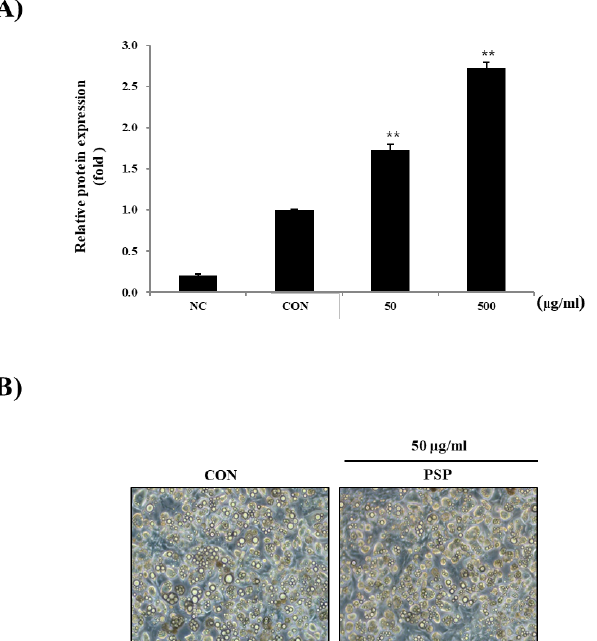
Figure 4. Effects of PSP on the differentiation of 3T3-L1 preadipocytes: ( A ) The expression of PPARγ in each experimental group. ( B ) A representative image of the control and PSP-treated cells at the end of the differentiation period (8–9 days). The cells were photographed under a microscope at 200 × magnification. Preadipocytes and mature adipocytes acted as the negative control (NC) and control (CON), respectively. All cell culture experiments are representative of three independent experiments. Data are presented as the mean ± SD of three independent experiments. ** p < 0.01, comparison to the control.